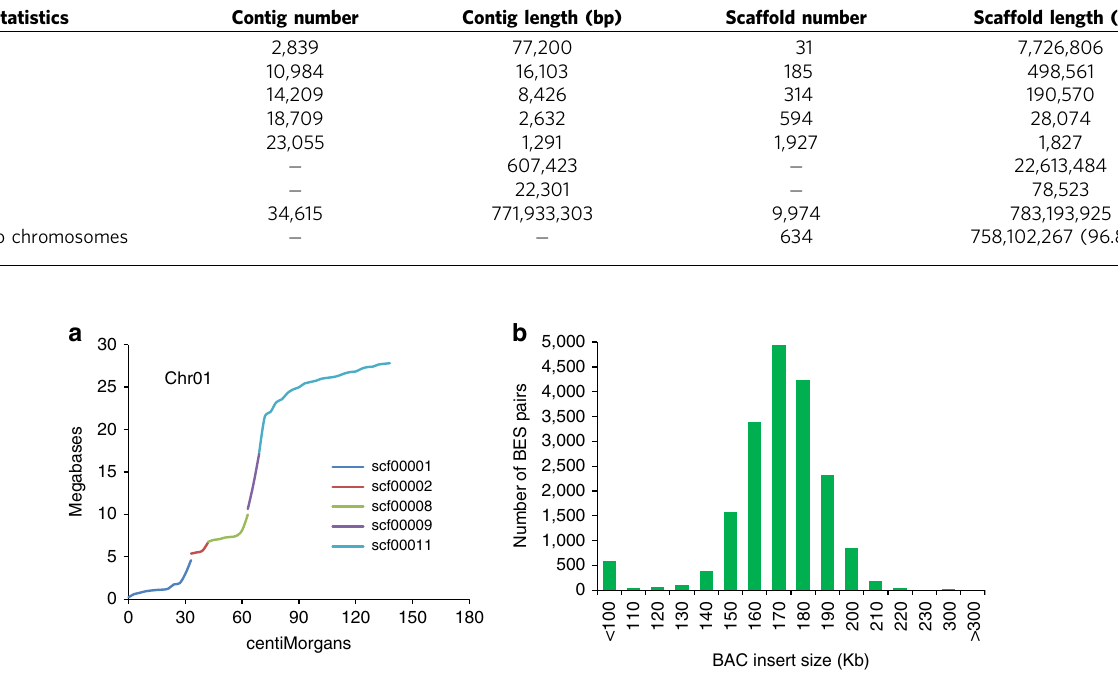
Figure 1 | Assessment of assembly accuracy. ( a ) Concordance of SNP marker positions on scaffolds of reference sequence with those on genetic linkage map, with chromosome 1 (linkage group 1 ¼ 139.5cM) being shown here. Scaffolds that span o 3cM each were omitted from the graph. (Graphs for all 29 chromosomes are shown in Supplementary Fig. 2). ( b ) Distribution of insert size of BAC clones on the reference genome sequence that was estimated with an average insert size of 161Kb (ref.